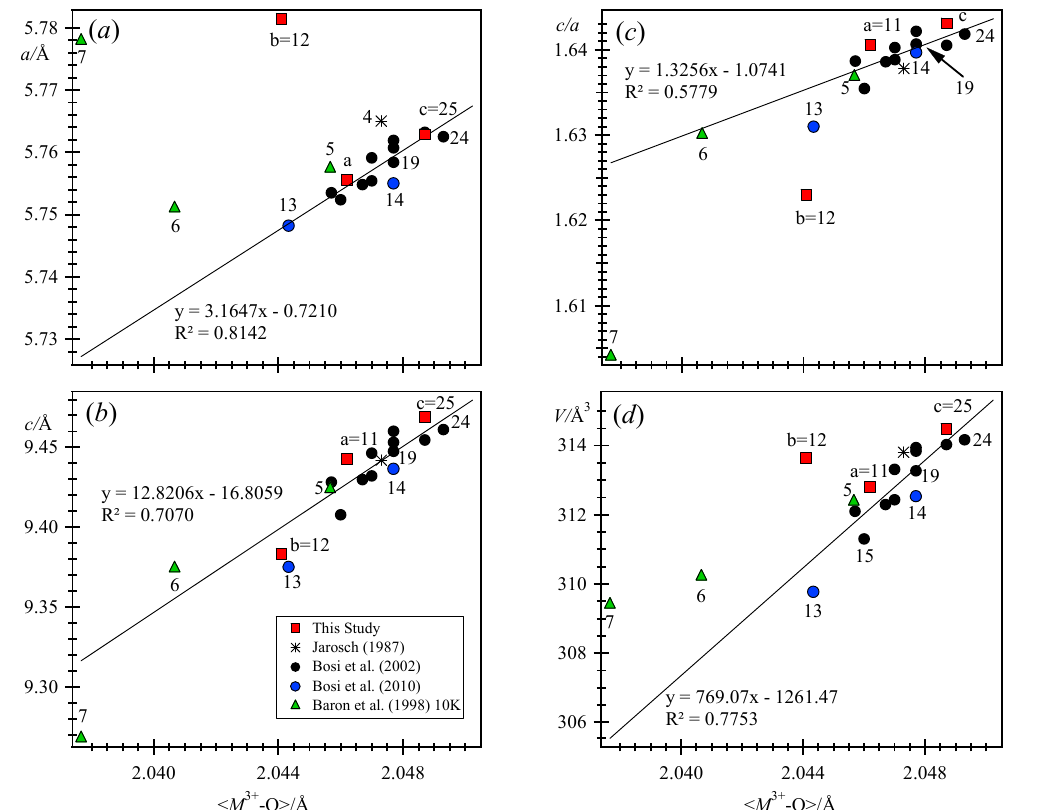
Figure 5. The average < M –O > distance varies linearly with unit-cell parameters: ( a ) a , ( b ) c , ( c ) c / a ratio, and ( d ) V (data from Table 1). Samples-a and -c fall close to the trend lines, but samples-b and -7 are o ff those lines. Pure Mn 3 O 4 has the largest average < M –O > distance (samples-c and -24) and the Mg-rich sample-13 has a small average < M –O > distance at room temperature.